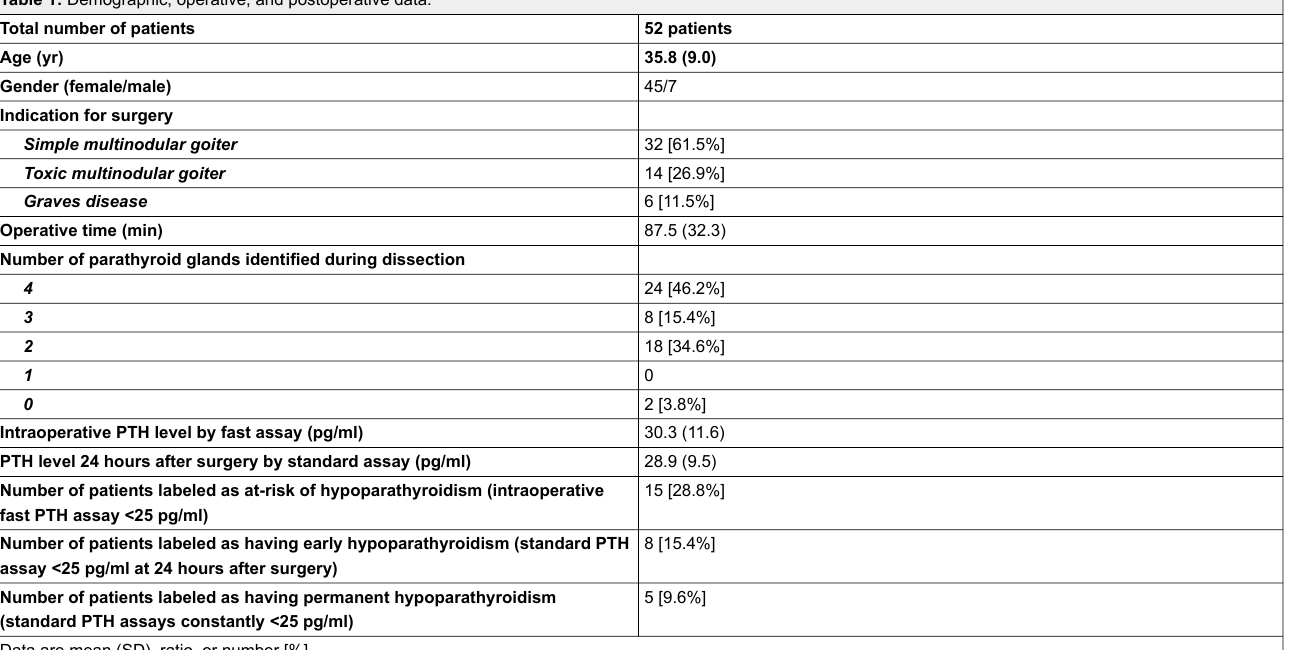
Table 1: Demographic, operative, and postoperative data. Total number of